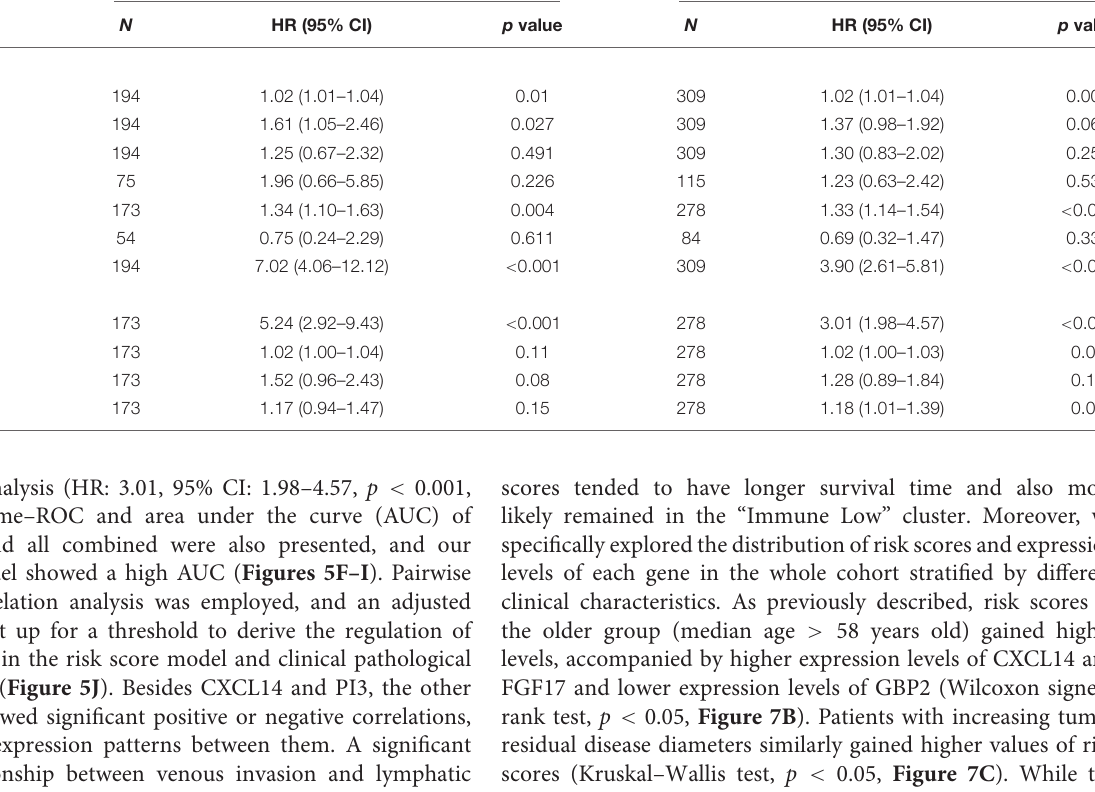
TABLE 2 | Univariate (A) and multivariate (B) Cox regression analysis of the risk score model and other clinical variables. Variables Immune High